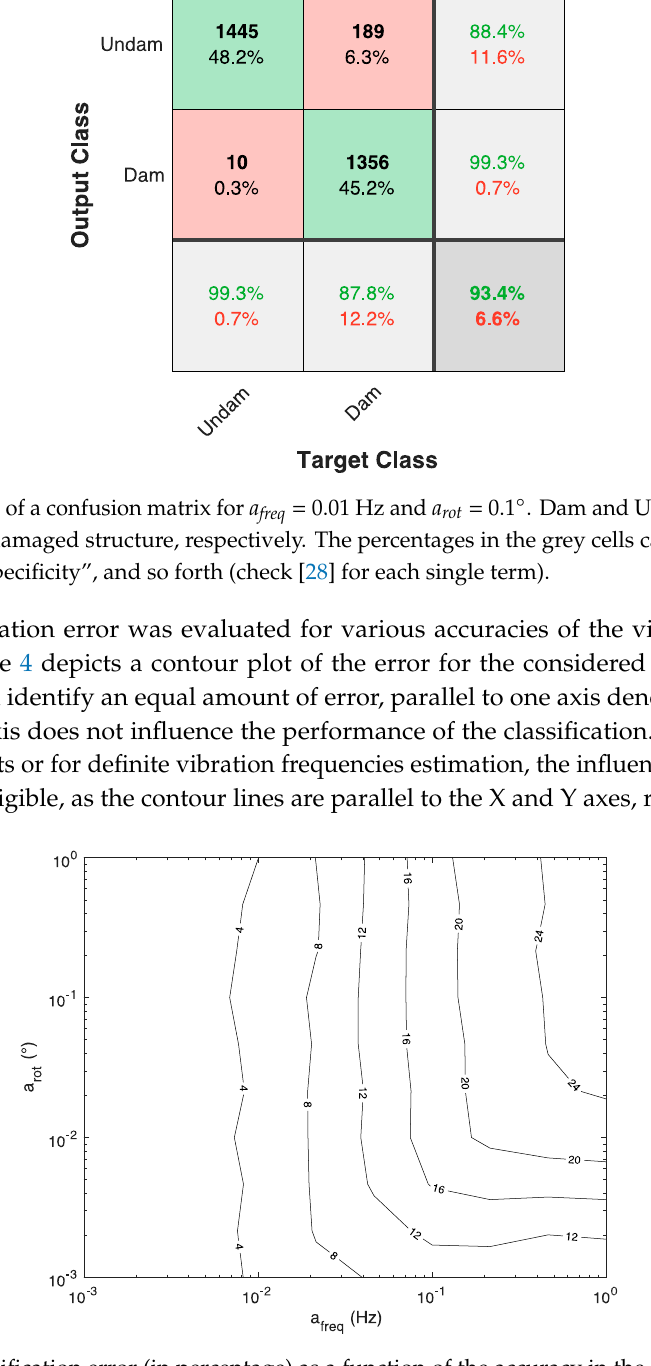
Figure 4. Misclassification error (in percentage) as a function of the accuracy in the estimation of the vibration frequency and in the measure of the rotation on log-log axes.